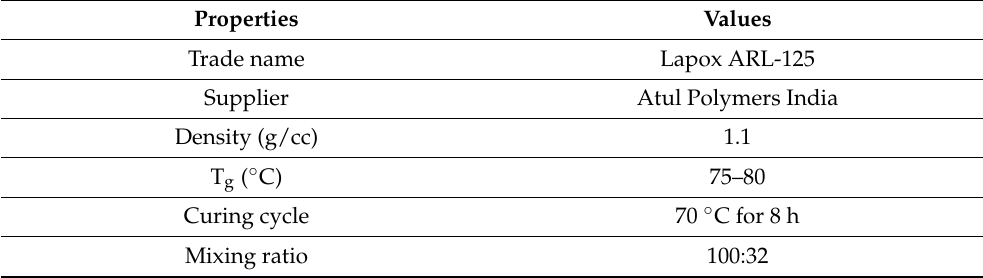
Table 1. (a) Details of epoxy resin